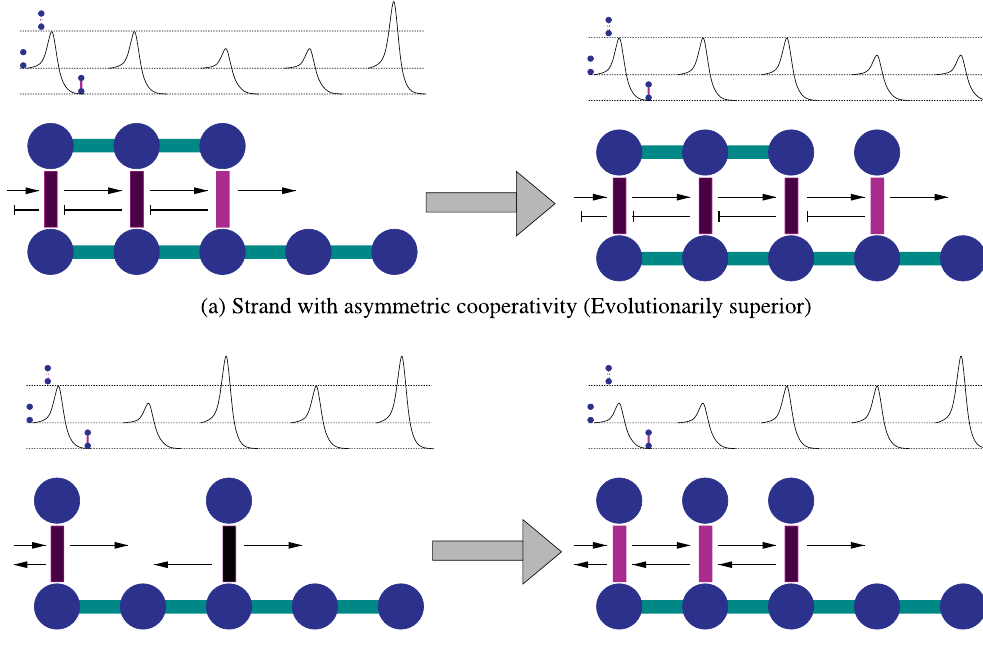
Figure 1. Illustration of replica strand construction process of a circular autocatalytic polymer in the presence of ( a ) asymmetric and ( b ) symmetric nearest-neighbor hydrogen bond cooperativities (reprinted from 12 with permission from Elsevier). The circles represent monomers and the thick vertical lines connecting a pair represent the inter-strand hydrogen bonds. Horizontal lines connecting the monomers represent covalent bonds between them. The color of the hydrogen bonds represent the height of the kinetic barrier separating bonded and unbonded configurations, higher the barrier, darker the color. Hydrogen bonding energy diagram is shown above for both cases of cooperativity. The bottom line of the three lines in the energy diagram corresponds to the energy of the bonded configuration, and the middle line corresponds to that of the unbonded configuration. Only a section of the circular strand is shown here for convenience. ( a ) In a strand with asymmetric cooperativity, the catalytic influence on and from a hydrogen bond’s left and right neighbors are unequal, simplified here to be catalysis and inhibition from left and right, respectively. Catalysis from a neighboring hydrogen bond is denoted by an arrow from the neighboring bond, and inhibition, with a bar- headed arrow. Such non-reciprocal, asymmetric catalytic influence among a pair of neighboring hydrogen bonds leads to low kinetic barrier for hydrogen bond formation/dissociation near the growth front, enabling faster monomer utilization for the replica strand construction. This also prevents the pre-existing hydrogen bonds behind the growth front from dissociation and provides them longer lifetime to facilitate covalent bond formation between the replica strand monomers. This asymmetrically cooperative hydrogen bonding behavior solves the conundrum of simultaneously requiring both low and high kinetic barriers for hydrogen bond formation/dissociation stemming from the conflicting needs of high monomer utilization and high covalent bond formation probability, but renders the strands directional. ( b ) In strands with symmetric cooperativity, two hydrogen bonds mutually catalyze each other’s formation/dissociation, by reducing the kinetic barriers symmetrically. In this case, already formed hydrogen bonds in regions away from the growth front (second bond from left) have smaller kinetic barriers than the bonds at or near the growth front (fourth bond from left). This reduces the template’s ability to attract monomers for replica strand elongation, and also its ability to keep the monomers bonded long enough to facilitate covalent bond formation, thereby reducing its replicative potential relative to templates with asymmetric cooperativity. Please note that the scales of energies in ( a , b ) are not the